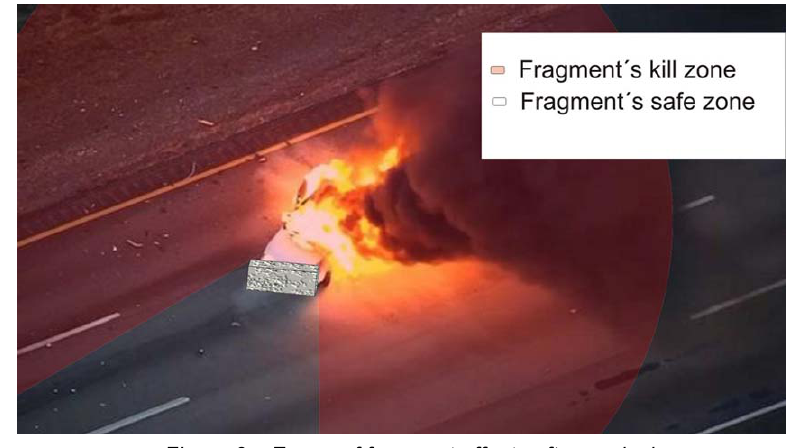
Figure 3 – Zones of fragment effects after explosion Рис . 3 – Зоны осколочного действия взрыва Слика 3 – Зоне парчадног дејства